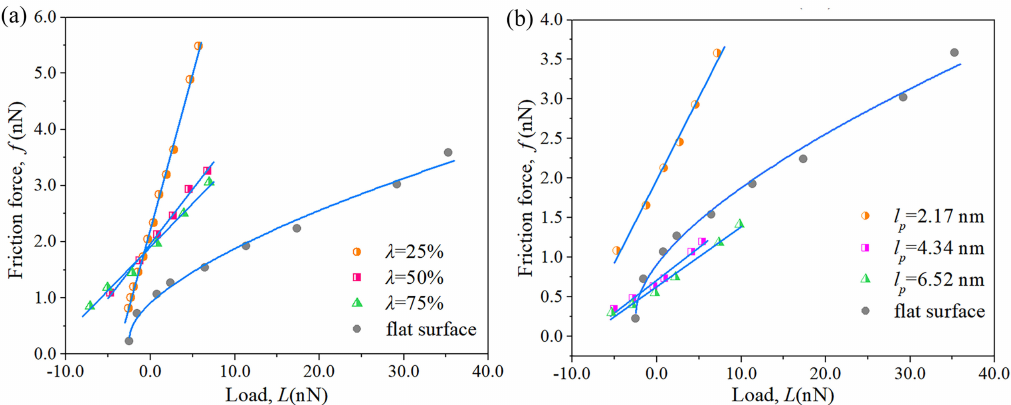
Figure 10. The effect of the area ratio ( a ), and nanopattern period ( b ) on the f–L dependence of the nanopatterned surface in adhesive